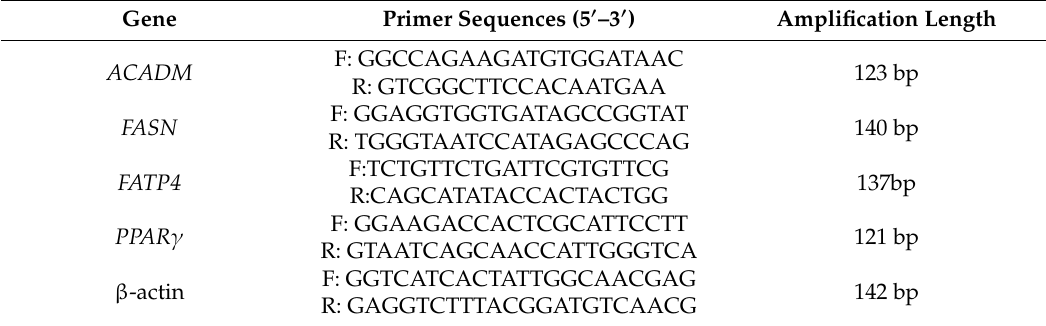
Table 2. The primer sequences used for quantitative reverse-transcription (qRT-)PCR.